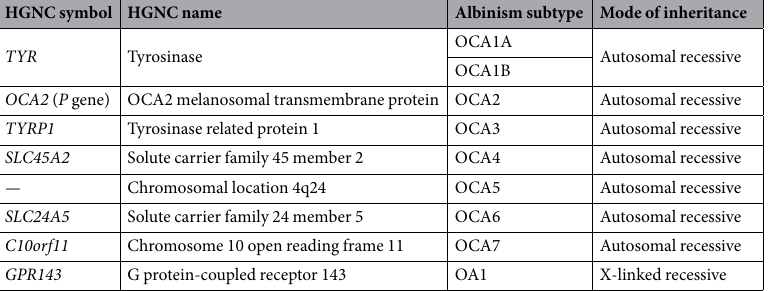
Table 1. Table to describe HGNC approved gene names associated with the subtypes of OCA and OA. OCA5 has been attributed to a chromosomal location but does not yet have an associated gene 46